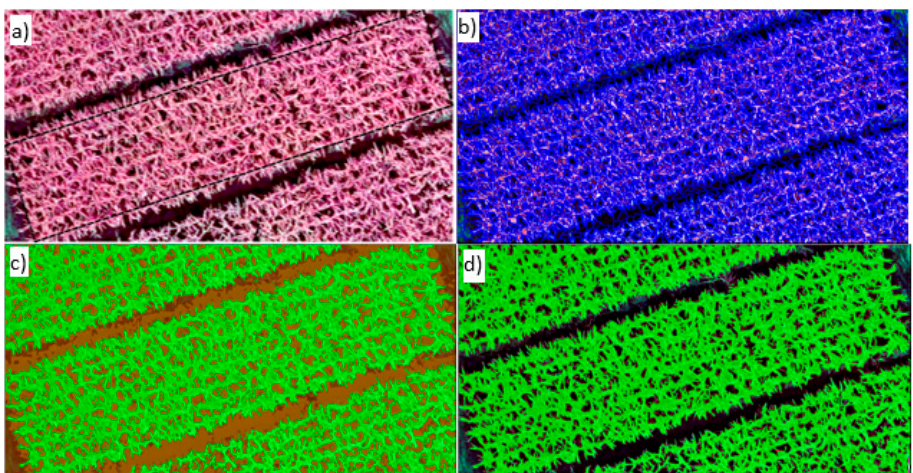
Figure 4. Resulting processed UAV-images for ( a ) Ortomosaic ( b ) OBIA segmentation, classification images with ( c ) three classes (vegetation, soil, shadow) and ( d ) only one class (vegetation). In this way, f v values are only estimated on vegetation pixels. The f v values for each plot were obtained by the following equation.